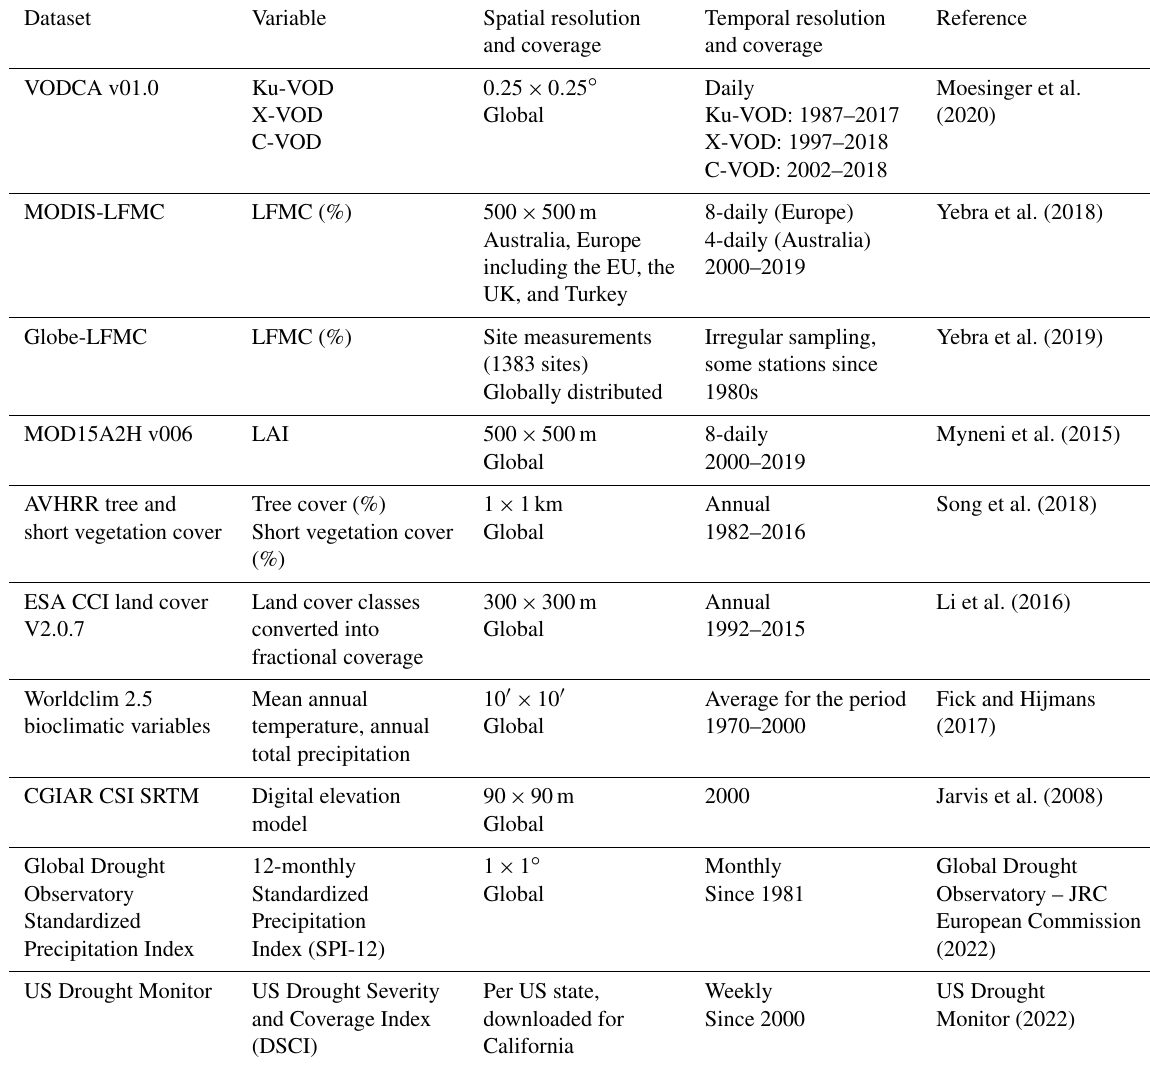
Table 1. Properties of the used